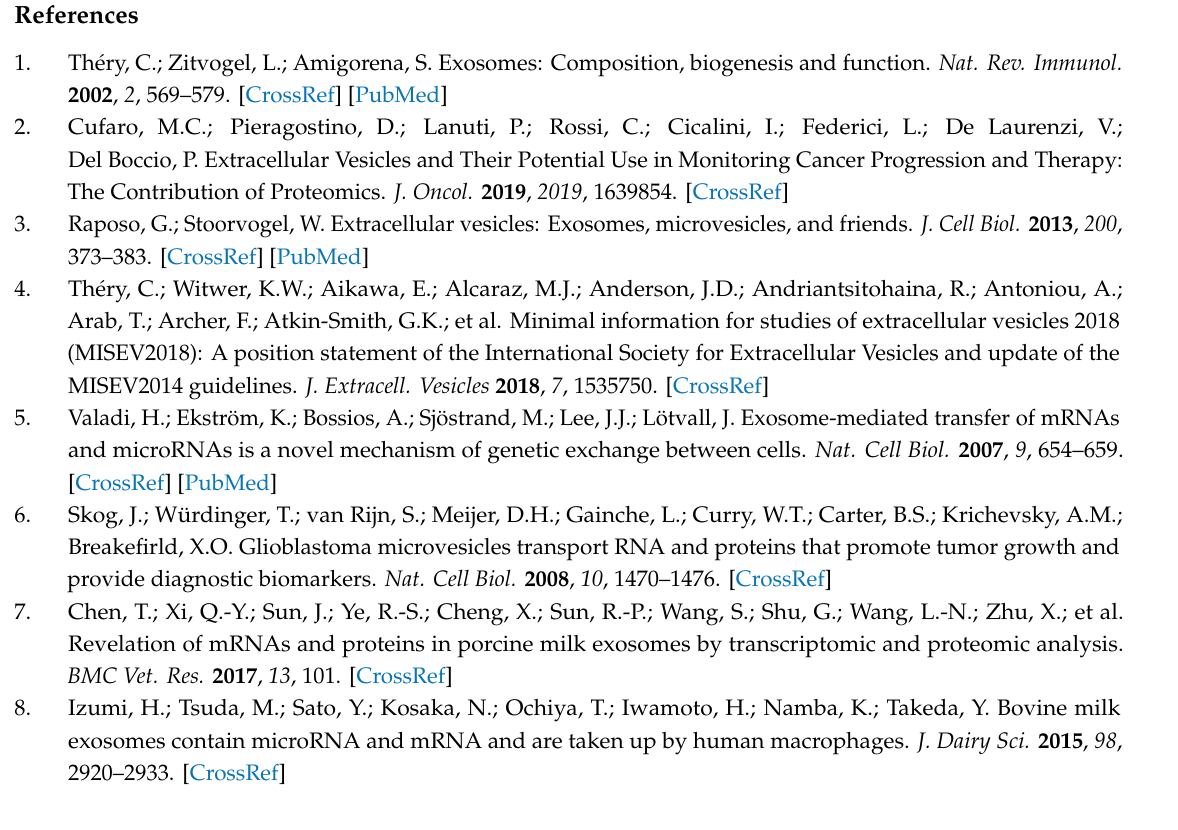
Table S1: DEGs (up-regulated and down-regulated) in milk EVs from BLV-infected cattle with HPL in Experiment 1; Table S2: DEGs (up-regulated and down-regulated) in milk EVs from BLV-infected cattle with HPL + HLDH in Experiment 2; and Figure S1: Representatives of morphological features of milk EVs from BLV-infected and uninfected cattle by transmission electron microscopy